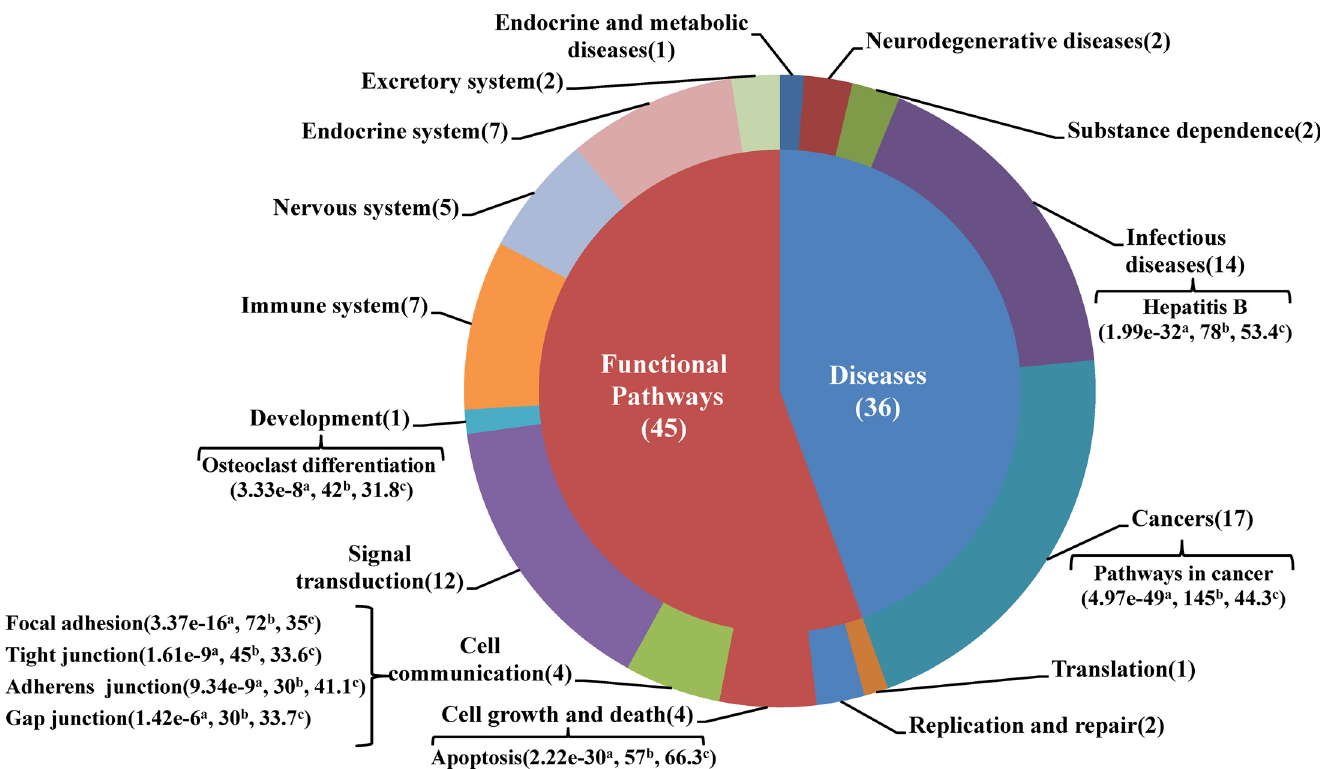
Fig 4. Subclasses of enriched KEGG pathways. The number of pathways belong to each subclass is shown in parentheses. Pathways mentioned in section 3.2 are labeled. a : Benjamini and Hochberg adjusted p-value; b and c : Number and percentage of associated genes in each pathway. Percentage represents the proportion of associated genes in all known genes involved in a